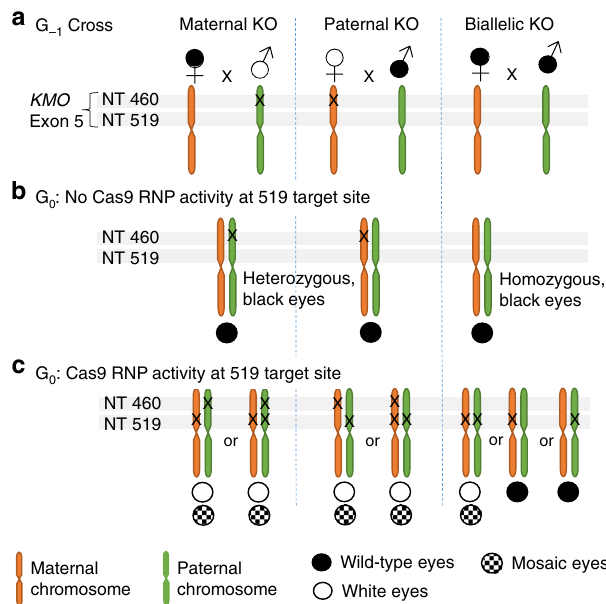
Fig. 4 Crossing scheme for distinguishing maternal and paternal kmo allele editing. a Homozygous, white-eye female or male mosquitoes (open white symbols) with a deletion on the kmo gene exon 5 at nucleotide (NT) 460 were outcrossed to wild-type mosquitoes (black symbol) to identify the effects of Cas9 activity in single chromosomes (paternal or maternal). Wild type intercrosses were used to test for simultaneous gene editing in the paternal and maternal chromosomes. An “ x ” on the illustrated chromosome indicates mutation at that site. b Genotype and phenotype resulting from the G 0 crosses in the absence of Cas9 activity; there is no mutation on the 519 site, the progeny are either heterozygous for mutation at 460 or wild- type homozygous, and therefore the phenotype of individuals is wild type. c Genotype and phenotype resulting from the G 0 crosses in the presence of Cas9 activity at the 519 site. Progeny from intercrosses are white or mosaic eyes. Monoallelic activity at the 519 site is undetectable in G 0 progeny from the G − 1 wild-type intercross, but biallelic activity is detectable as white eyes or mosaics. Further crossing of G 0 can lead to detection of